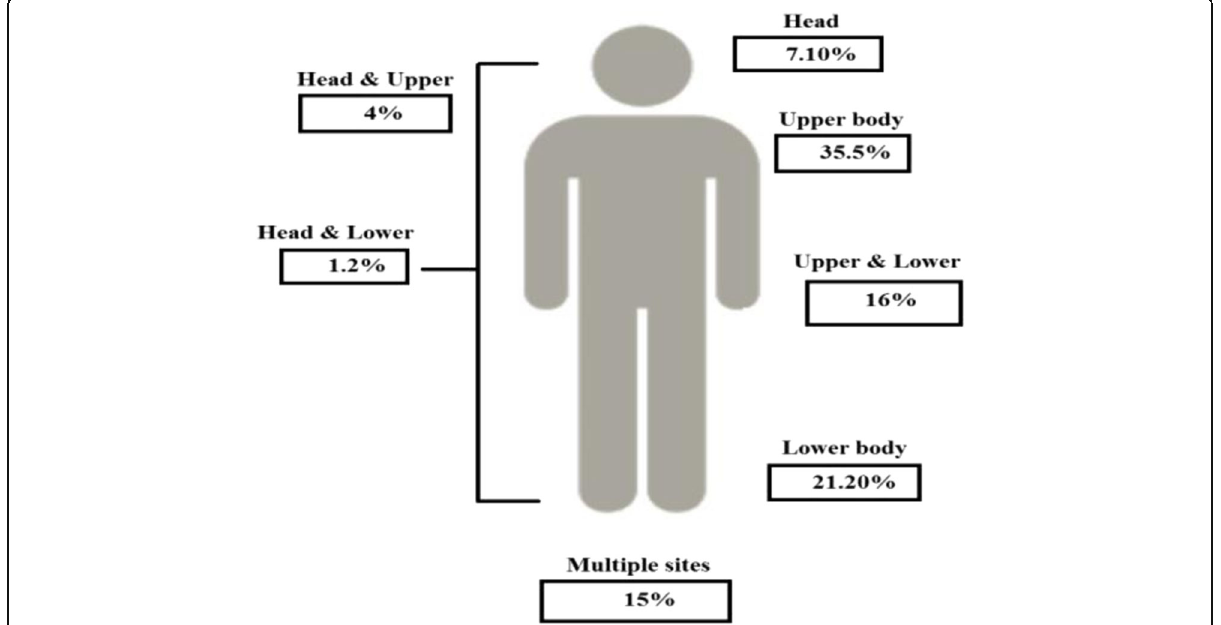
Fig. 1 Anatomical site of war-related injury by type. Data from 2014 Gaza war